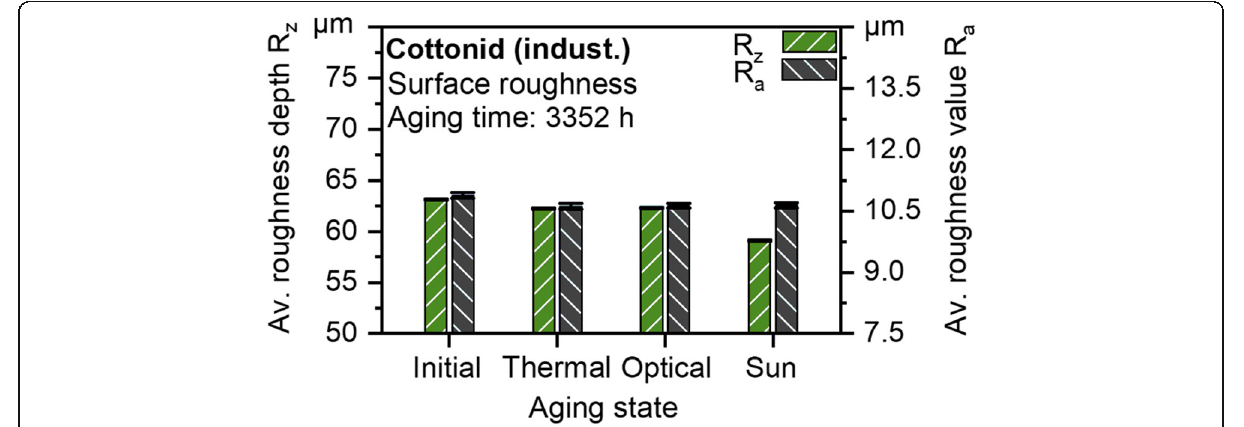
Fig. 7 Roughness measurements on surface of industrial Cottonid material (Ernst Krueger) in different aging